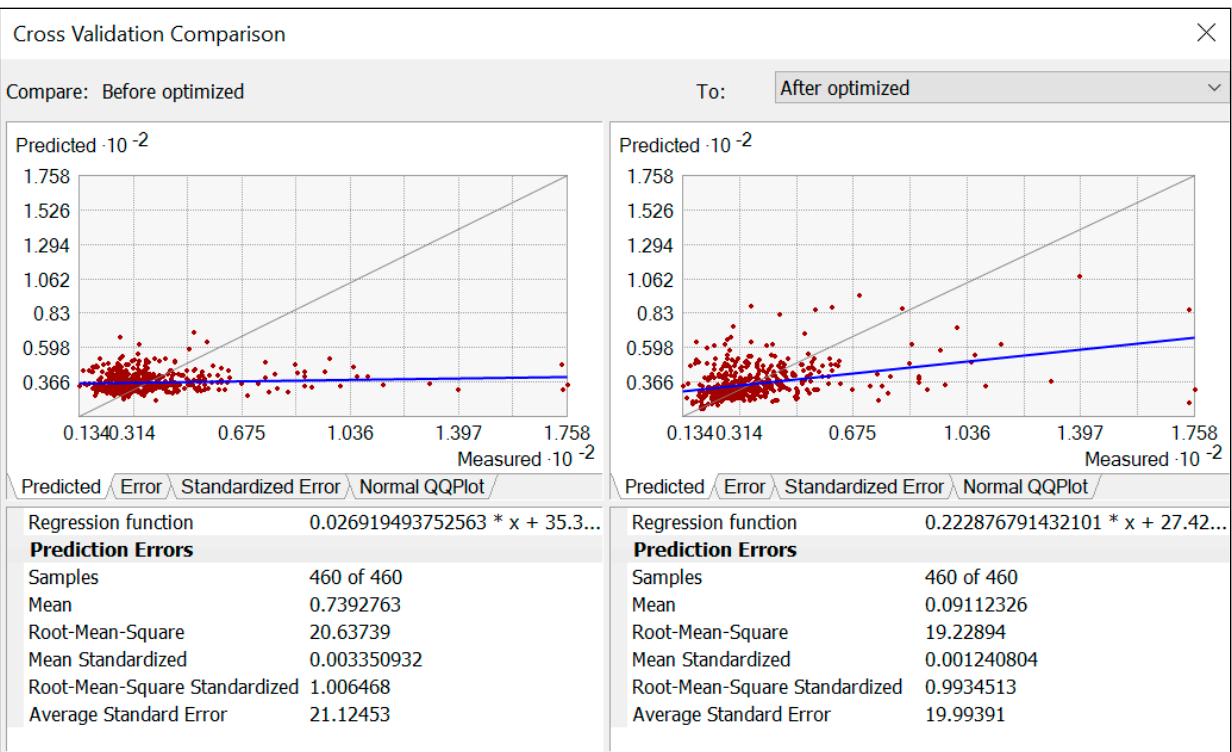
Figure 4. Prediction error cross-validation comparison before and after the original sampling configuration optimized by using SSA.